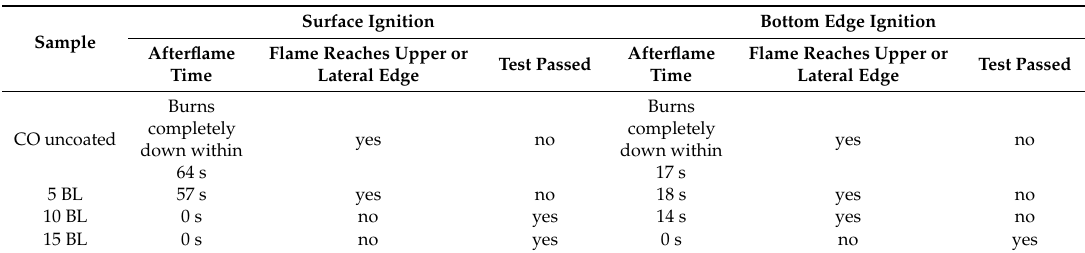
Table 5. Flame test results of coated cotton samples according to ISO 15025:2016. The stated rating—pass, no pass—is based on two criteria specified in ISO 11611:2015.